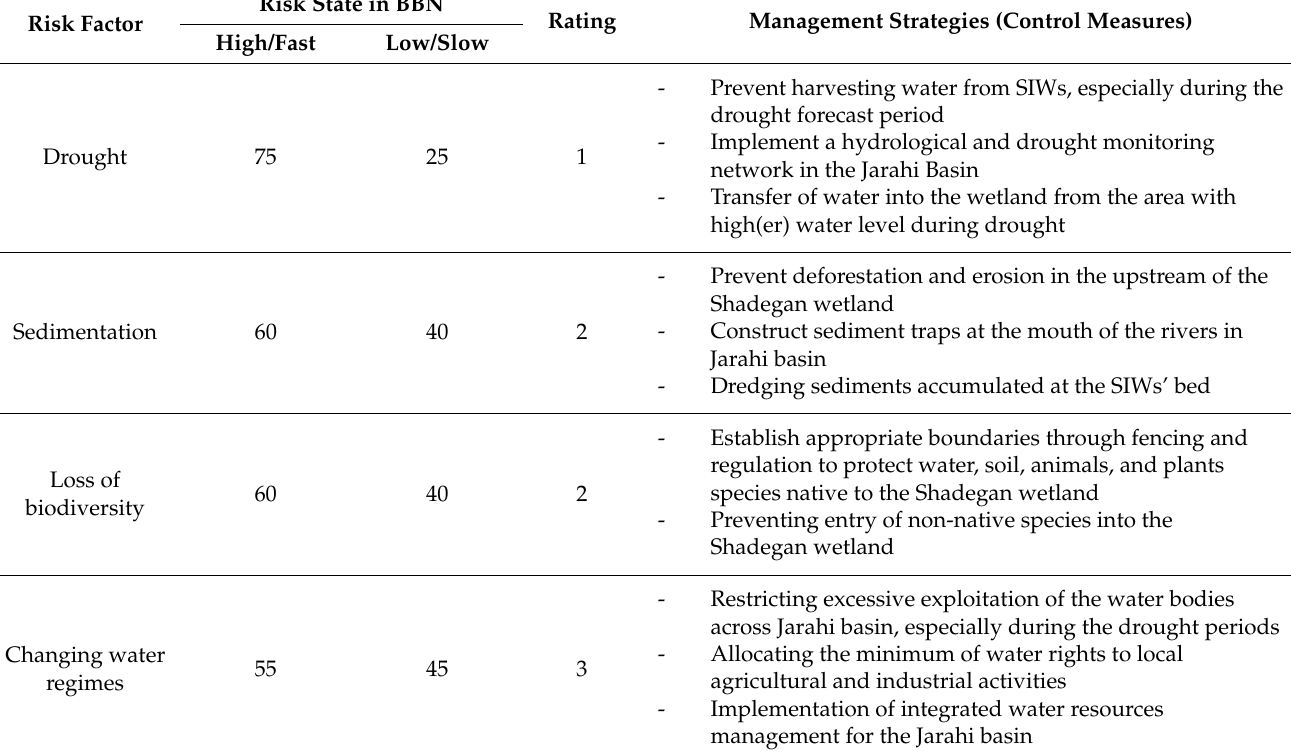
Table 3. Management strategies for reducing the most pressing environmental risks at